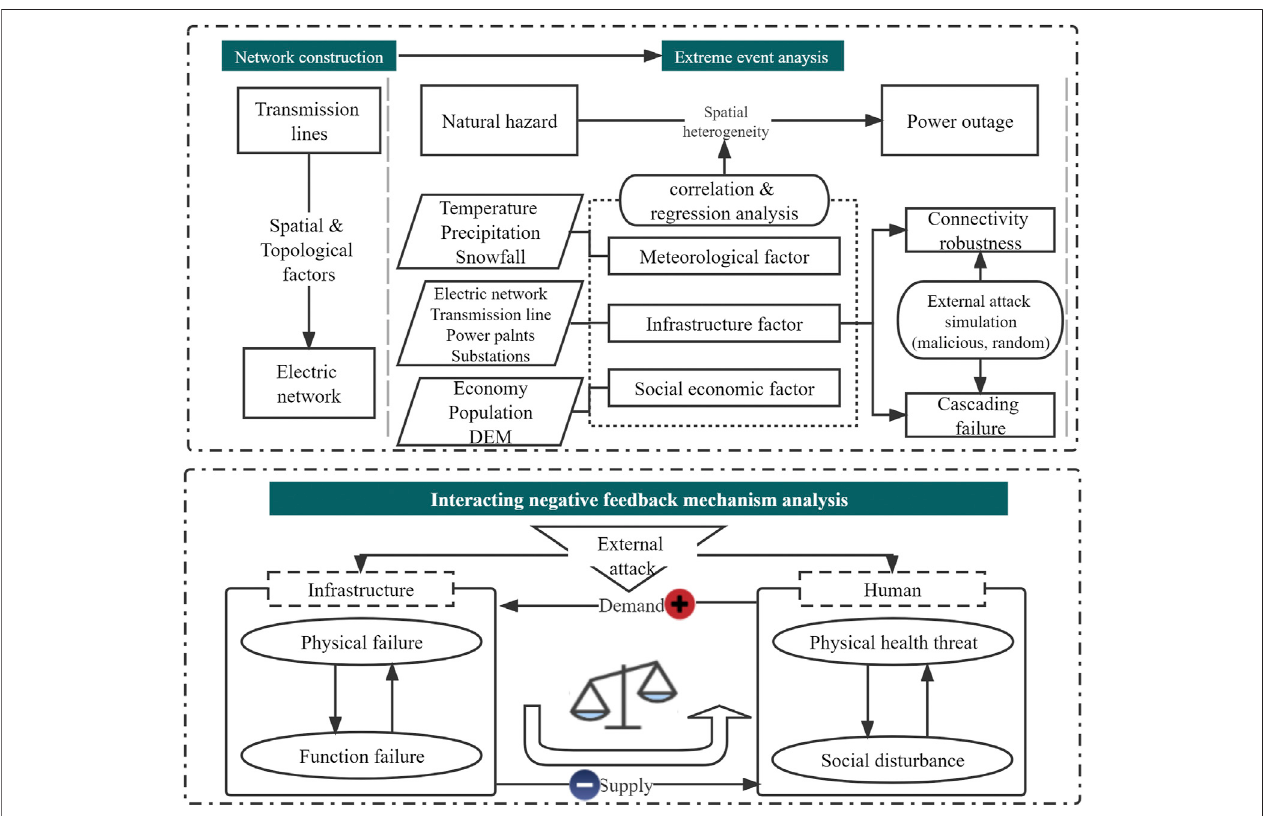
FIGURE 1 | Framework of this